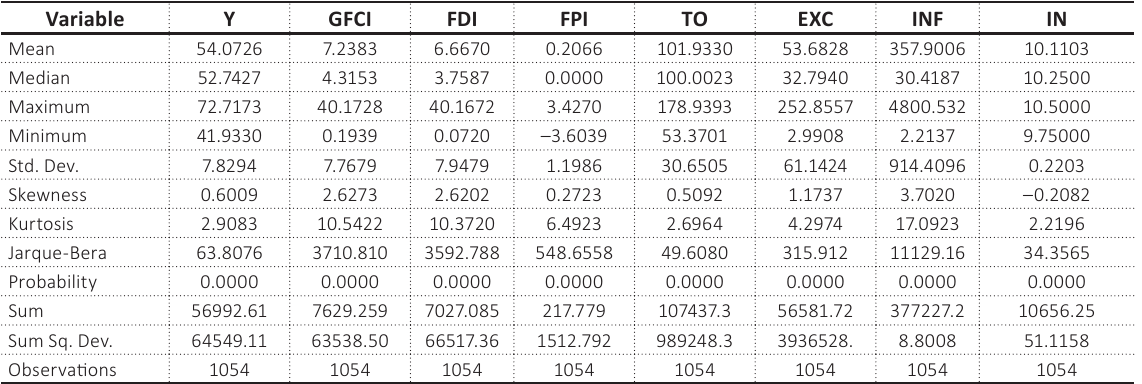
Table 1. Summary statistic